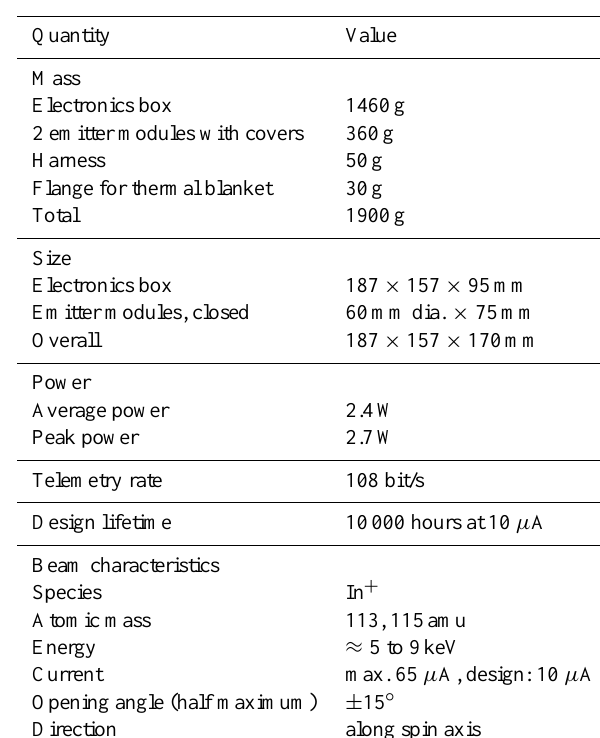
Table 1. Instrument data